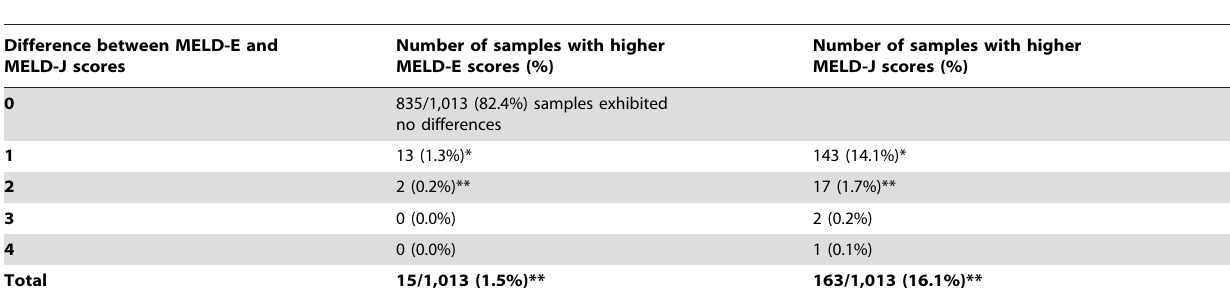
Table 2. MELD scores for the creatinine measurements that were obtained using the enzymatic assay (MELD-E) and the Jaffe´ method